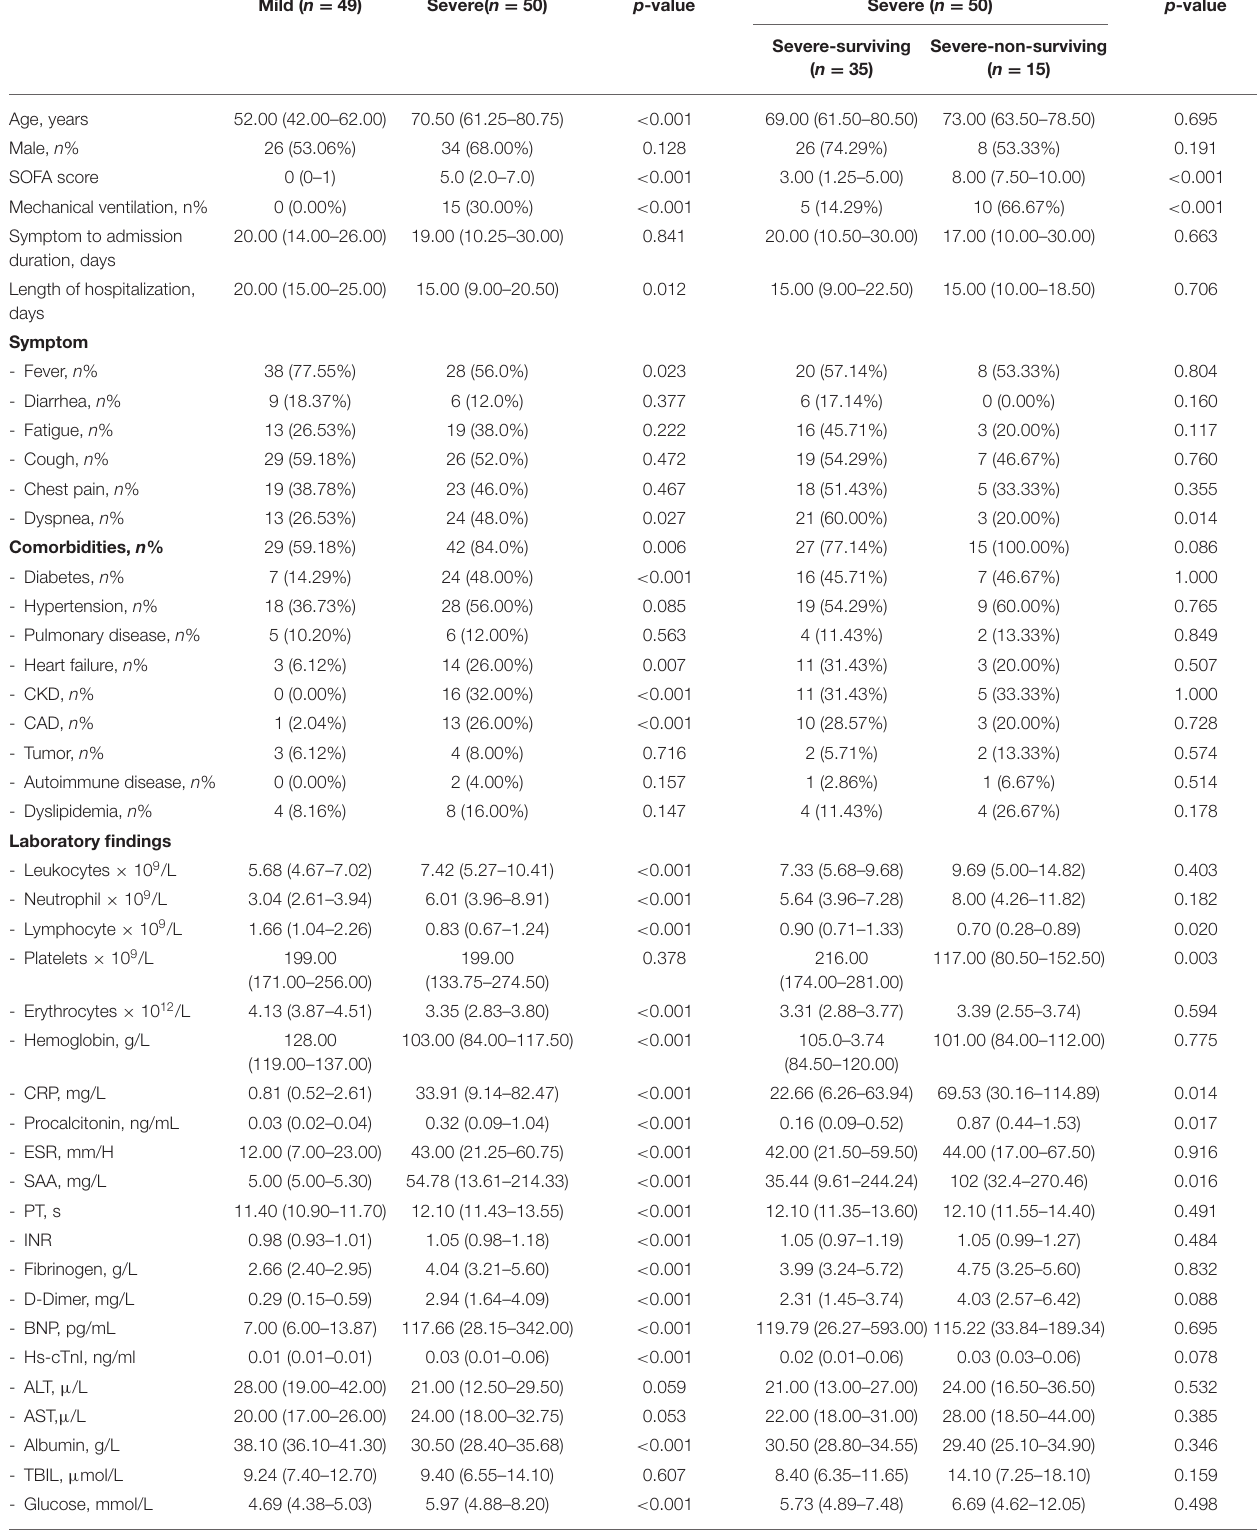
TABLE 1 | Clinical characteristics and laboratory assessments in COVID-19 patients. Mild ( n = 49) Severe( n = 50) p -value Severe ( n = 50) p -value